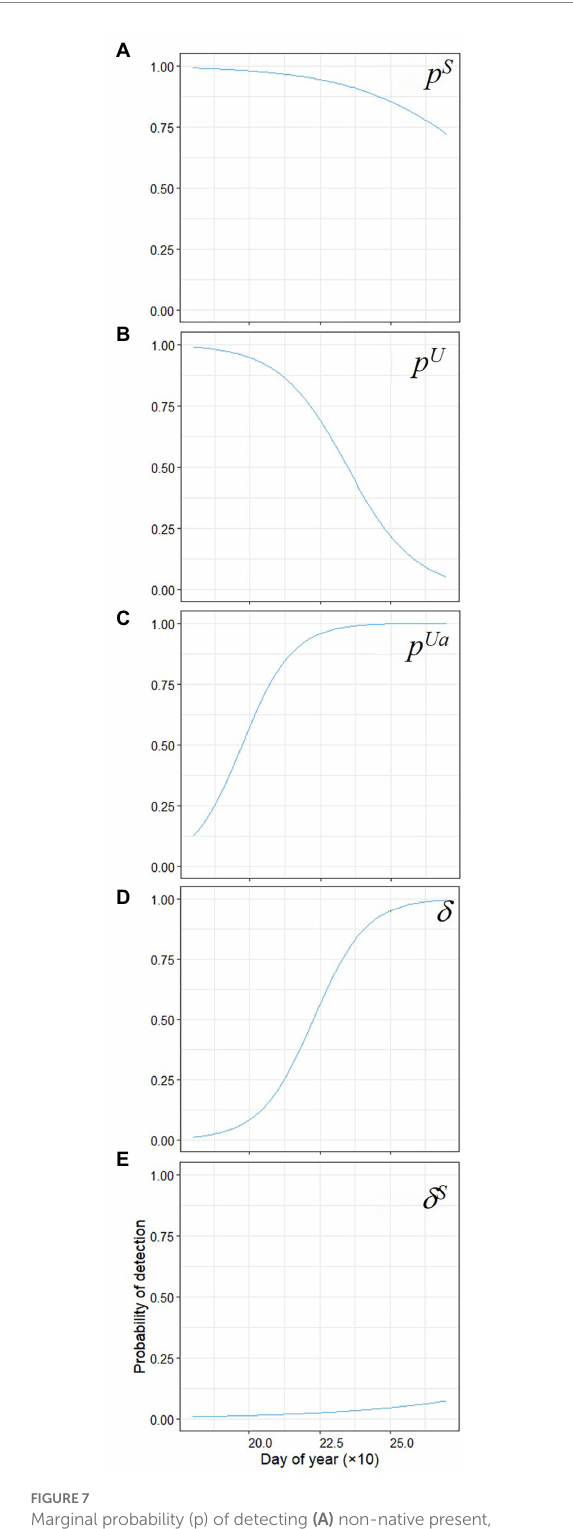
FIGURE 7 Marginal probability (p) of detecting (A) non-native present, (B) native chub present/ non-native bass absent, (C) native abundant/ non-native absent, (D) evidence of the native abundant/ given non-native bass absent, (E) evidence of abundant native/ non-native present with day of year. Day of year 175 = July 1 and 280 = September